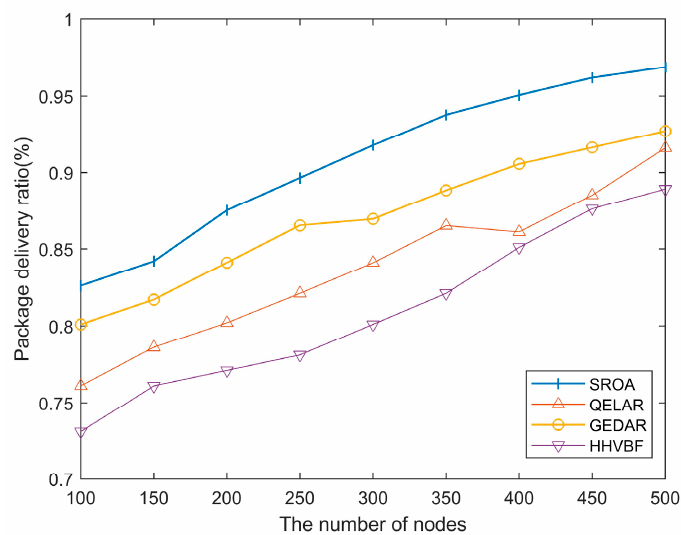
Figure 11. Comparison of the packet delivery ratio for the four protocols.